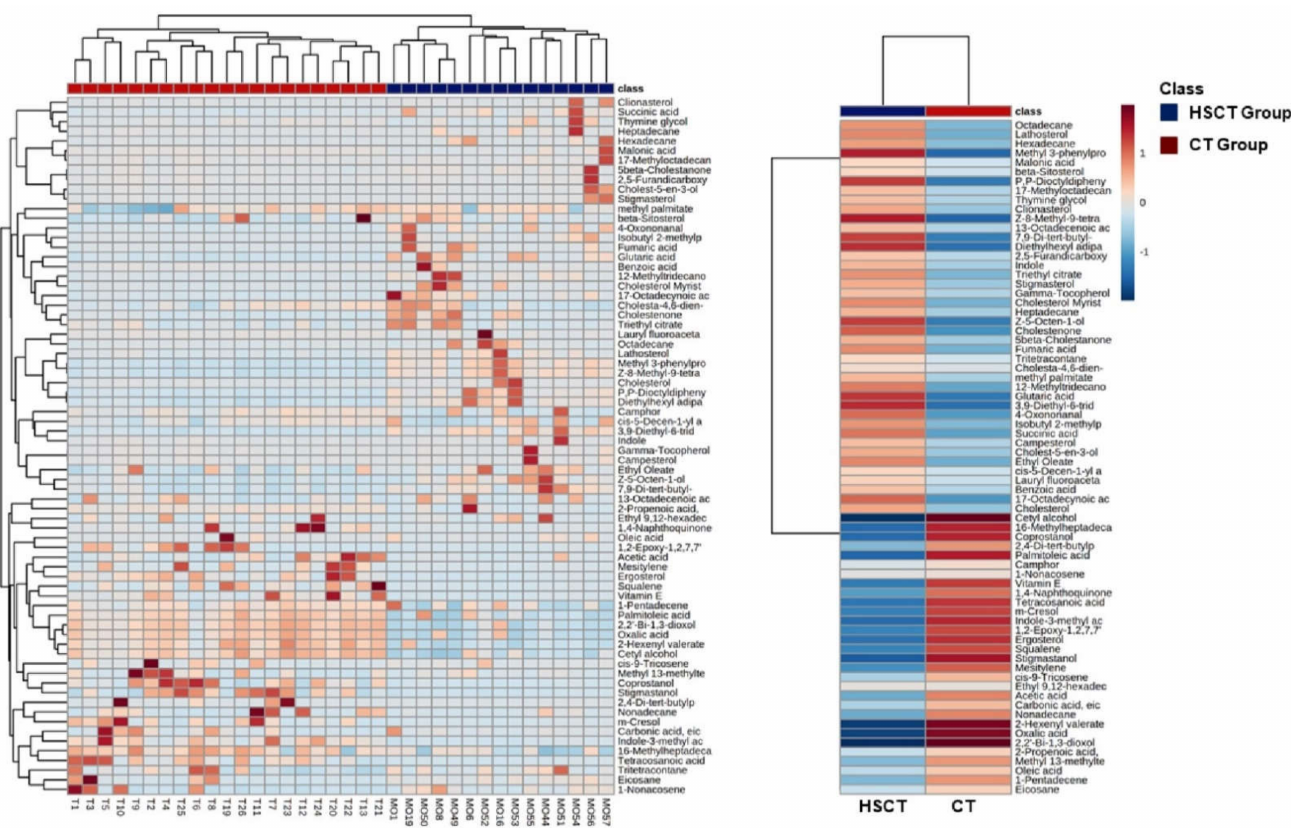
Figure 6. Fecal metabolic differences among groups: heatmaps of differential metabolites among the groups. The color of each section represents the significance of the change in metabolites (red: upregulated; blue: downregulated). Rows: metabolites; columns: